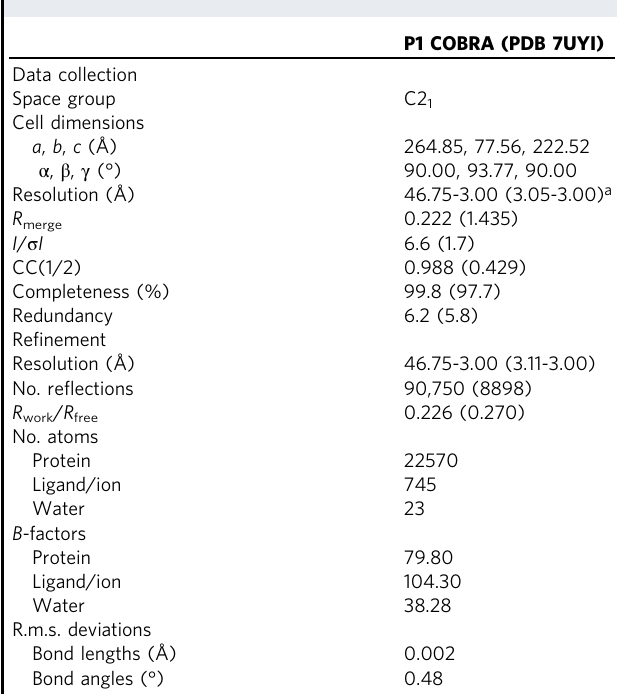
Table 1 Data collection and re fi nement statistics (molecular replacement).